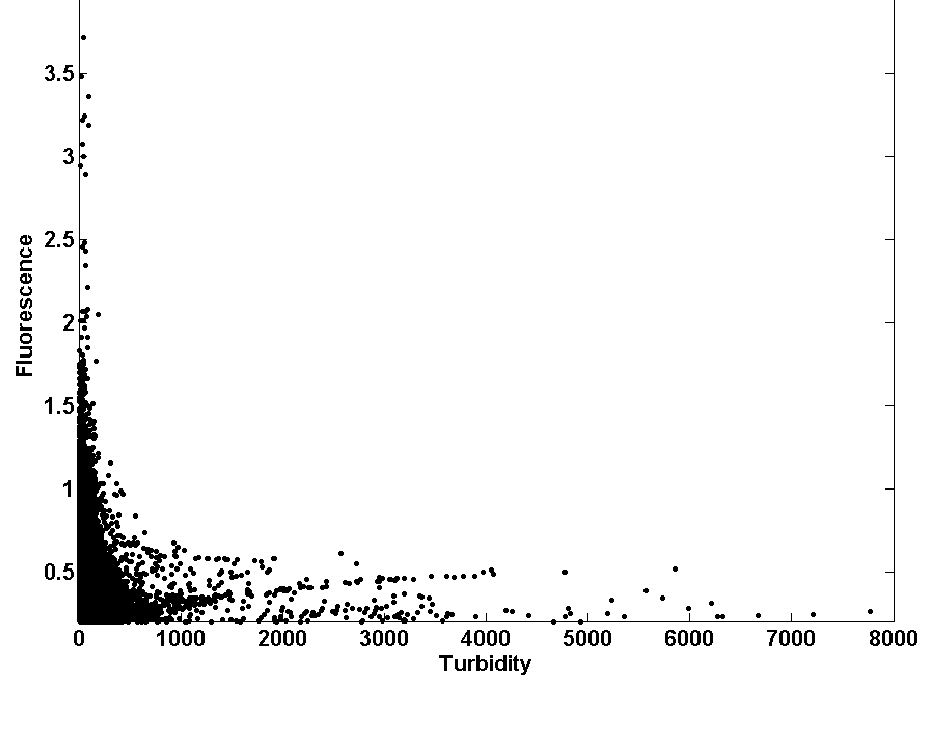
Figure 6. Turbidity (in F.N.U.) vs. fluorescence (in r.u.) measured by RTRM in the node